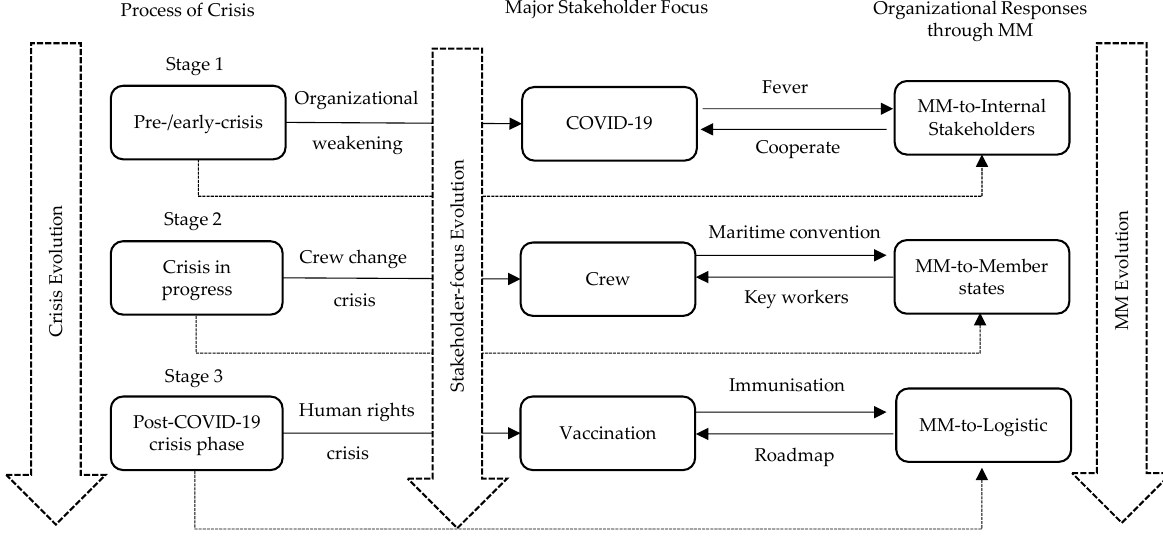
Figure 3. Evolution of Organizational Crisis Response via maritime management (MM).